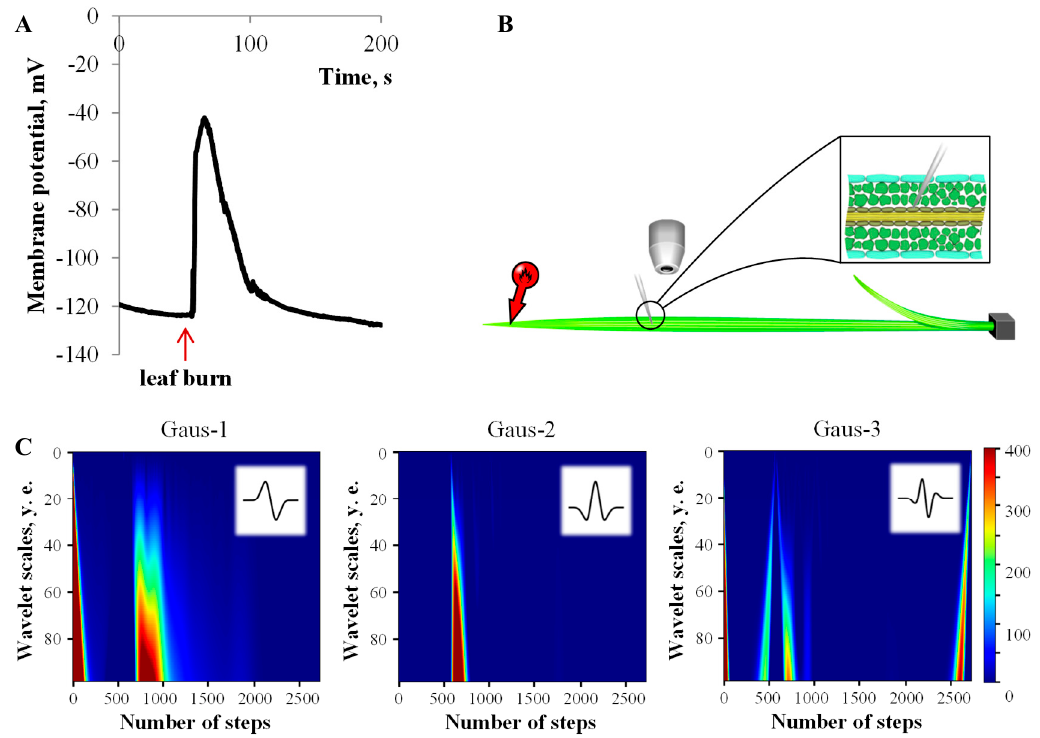
Figure 2. The typical intracellular record of the variation potential induced by burn of the wheat leaf tip and registered from the wheat cell by the microelectrode technique ( A ), a scheme of the experiment ( B ), and scalograms of the signal record wavelet transform by means of first- to third-order Gaussian basses ( C ). One step equals 0.1 s. The reaction started at 56 s, expressed as a local maximum on a scalogram.